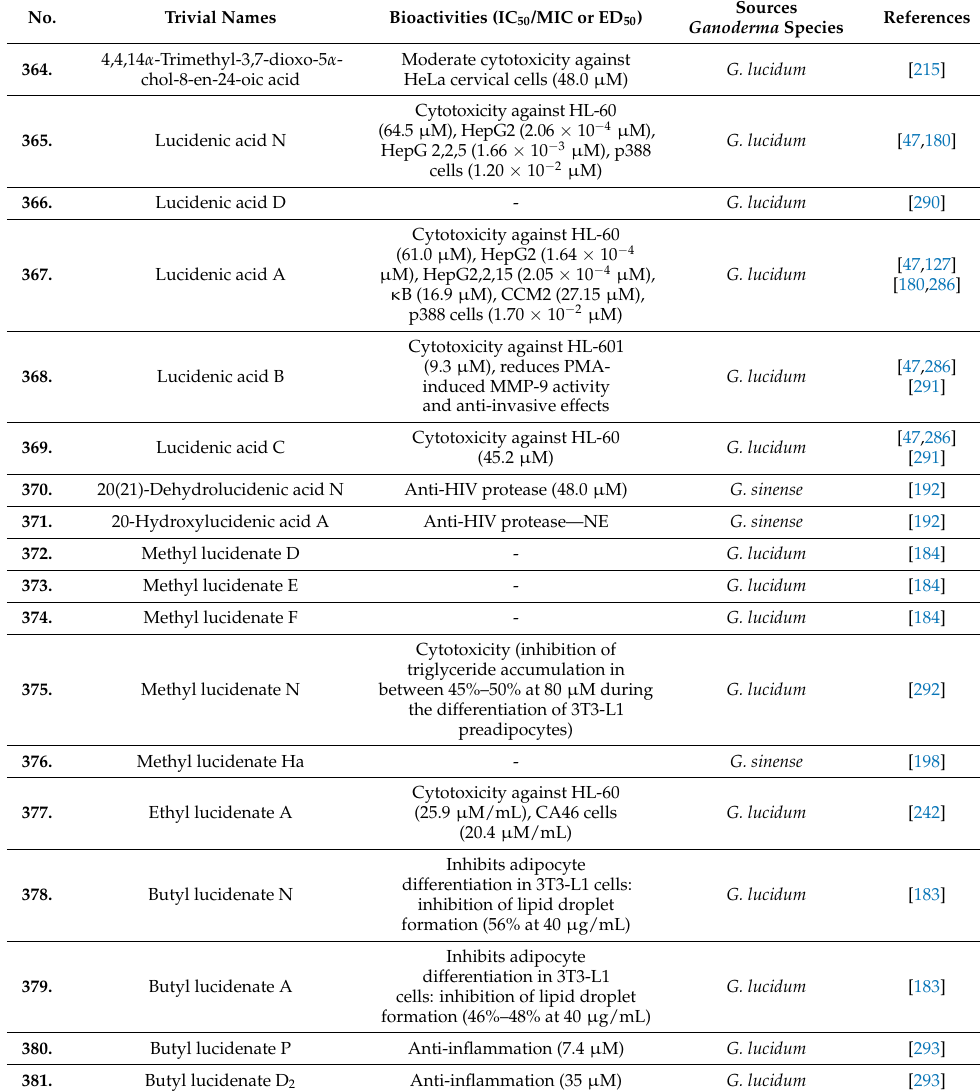
Table 3. C27 Triterpenoids and bioactivities from Ganoderma